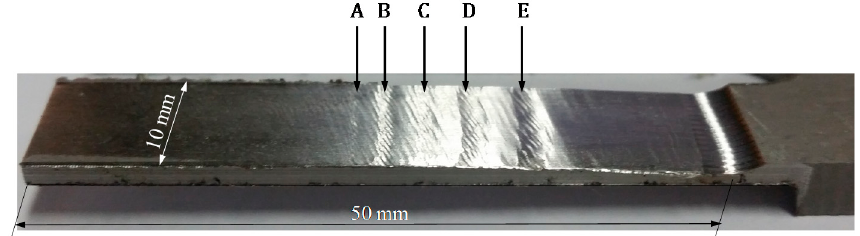
Figure 10. Machined workpiece with vibration marks.